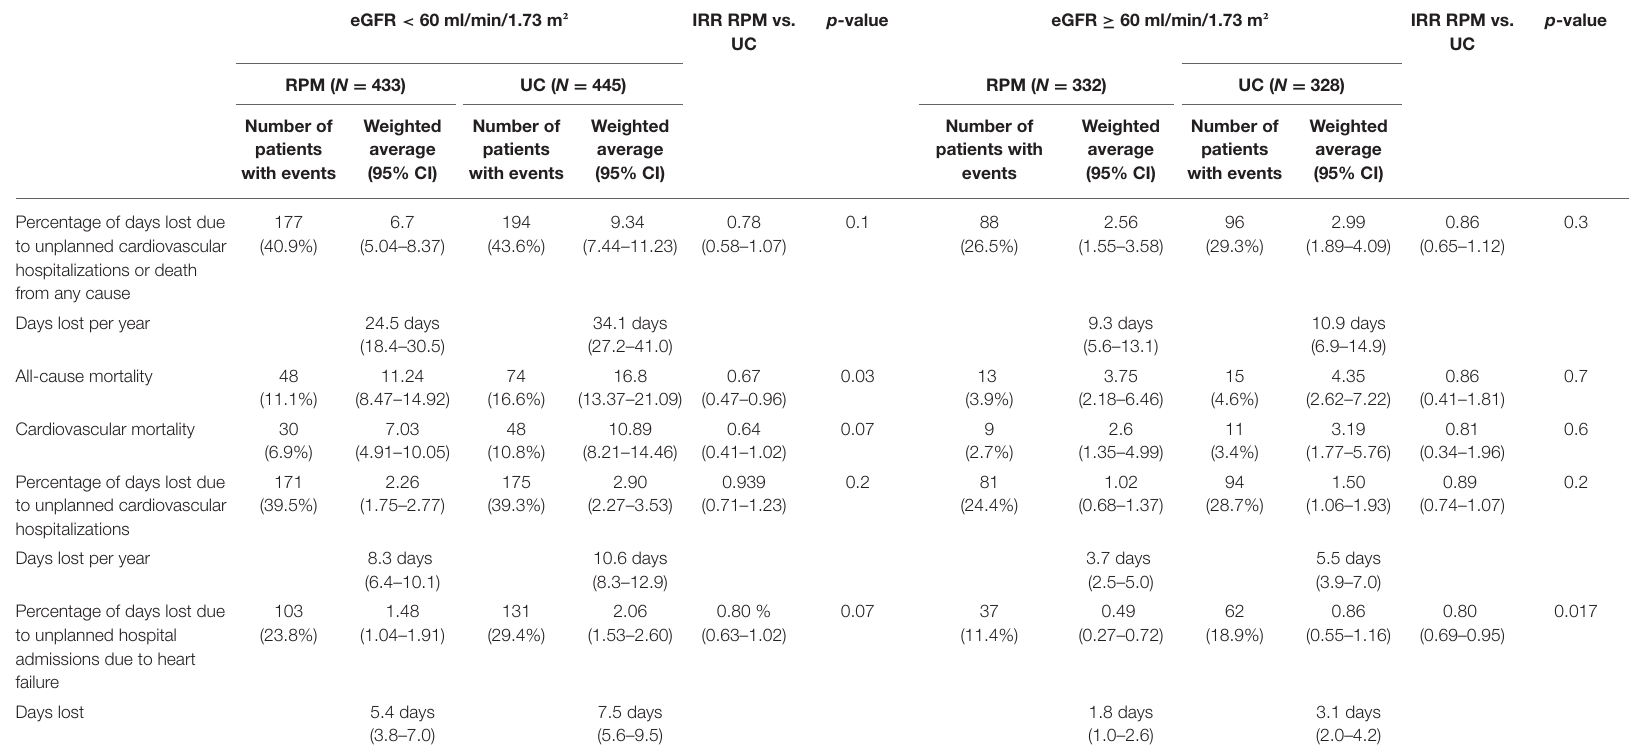
TABLE 3 | Outcomes comparing remote patient management (RPM) vs. usual care (UC) in patients with eGFR < 60 ml/min/1.73 m ² and ≥ 60 ml/min/1.73 m ² ,